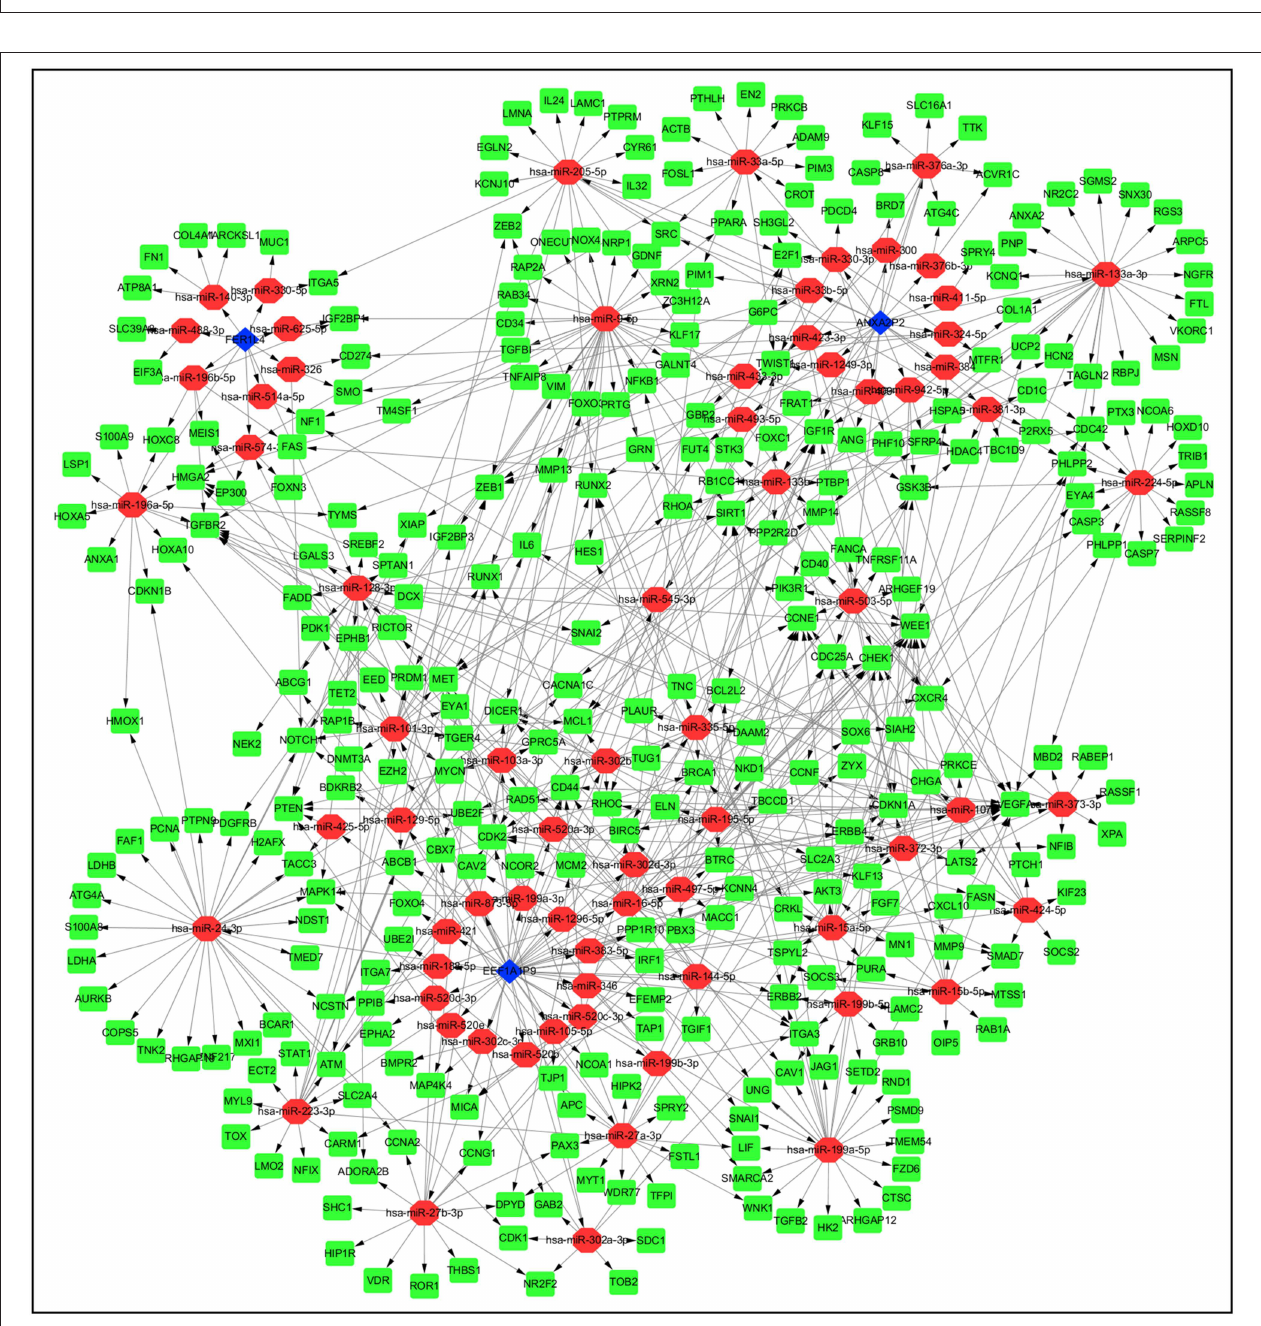
FIGURE 7 | Construction of pseudogene-miRNA-mRNA regulatory networks. Pseudogenes together with binding miRNAs and target genes related to the three pseudogenes with | r | ≥ 0.4 were used to construct the pseudogene-miRNA-mRNA regulatory networks. Blue diamonds represented pseudogenes, which are located at the cores of the networks. Red ellipses and green rectangles stand for binding miRNAs and target genes, respectively. 0.001). Correspondingly, several KEGG pathways including focal to tumor apoptosis, proliferation, migration, and angiogenesis, adhesion, apoptosis, the PI3K-AKT signaling pathway, cell cycle, such as regulation of cell proliferation, cell migration, apoptosis, HIF-1 signaling pathway and ECM receptor interaction were response to hypoxia, and angiogenesis ( Figure 9A , FDR <